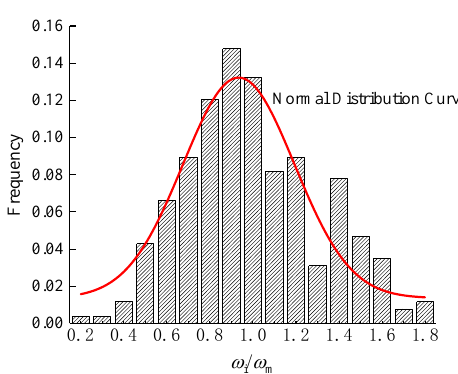
Figure 14. A histogram of the tested crack width distribution.